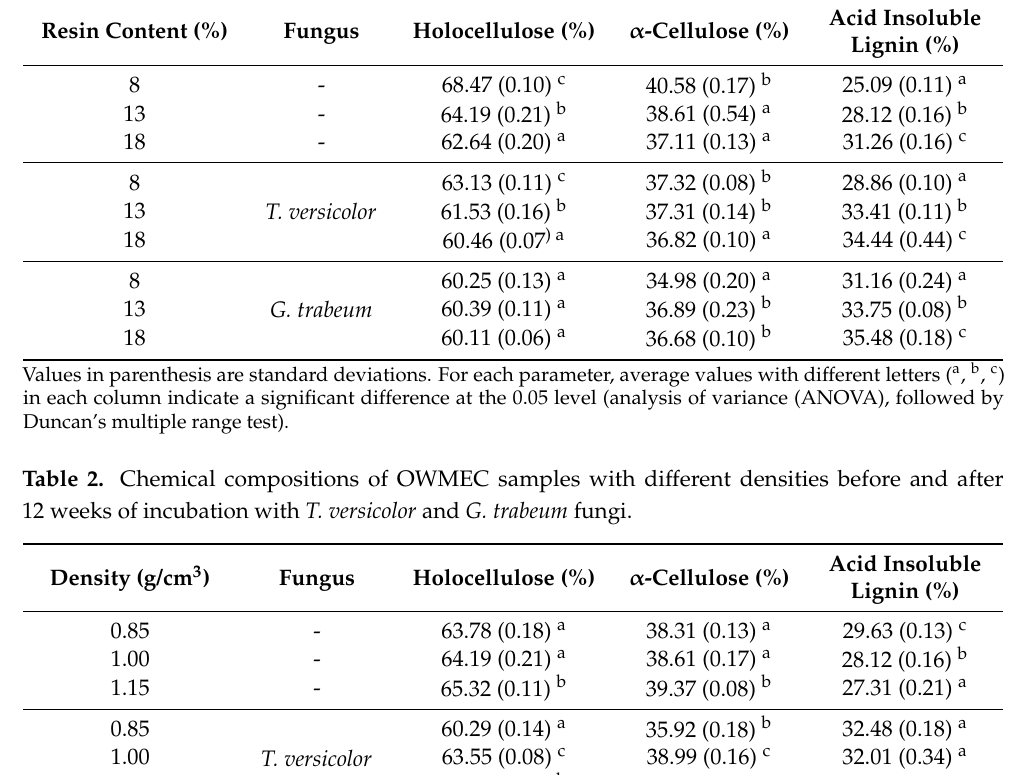
Table 1. Chemical compositions of OWMEC samples with different resin contents before and after 12 weeks of incubation with T. versicolor and G. trabeum fungi. Resin Content (%) Fungus Holocellulose (%) α -Cellulose (%)